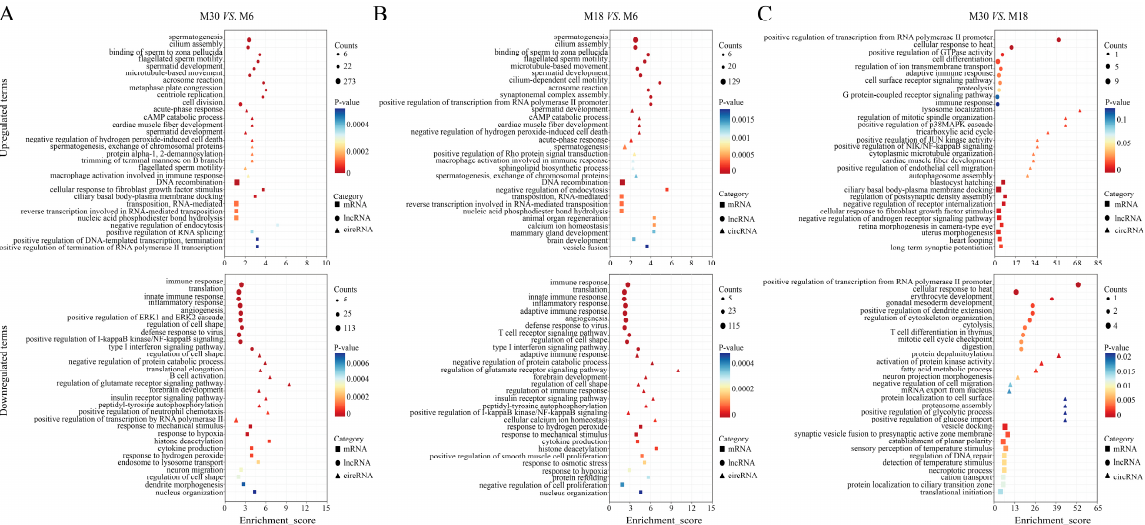
Figure 3. GO analysis of DE genes (including mRNAs, lncRNAs, and circRNAs) in the M30 vs. M6, M18 vs. M6, and M30 vs. M18 groups. ( A ) GO analysis of DE genes in the M30 vs. M6 group. ( B ) GO analysis of DE genes in the M18 vs. M6 group. ( C ) GO analysis of DE genes in the M30 vs. M18 group. The top 10 enriched GO terms ranked by p -values are shown ( p -value <